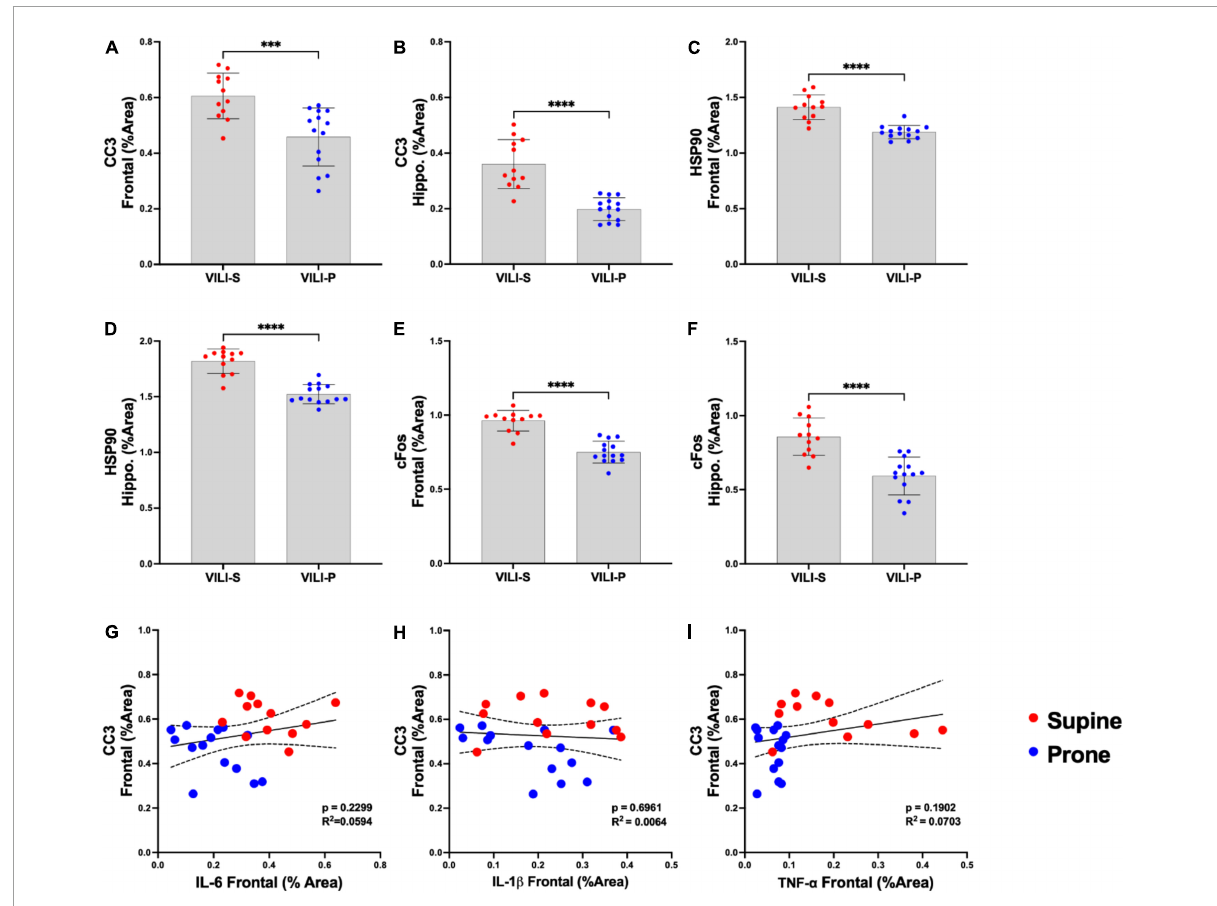
FIGURE2 Prone position during acute ventilator induced lung injury (VILI) decreases neuronal injury and stress. (A,B) Frontal cortex and hippocampal cleaved caspase-3 (CC3), a known early marker of apoptosis, was statistically significantly reduced in a prone compared to supine position ( p < 0.001). (C,D) In the prone position, heat shock protein 90 (Hsp90), a measure of cellular stress response, was significantly reduced in the frontal cortex and hippocampus ( p < 0.0001) in comparison to that of supine positioning. (E,F) Prone positioning significantly reduced frontal cortex and hippocampal neuronal activity (C–FOS) compared to supine ( p < 0.0001). (G–I) Regression analyses across both supine and prone groups demonstrated no statistically significant relationships between CC3 and inflammatory cytokines (IL-6, IL-1 β , TNF- α ) in the frontal cortex. Group sample sizes for all analyses were prone ( n = 14) and supine ( n = 12). Data are expressed as mean ± SD. ∗∗∗ p < 0.001, ∗∗∗∗ p <